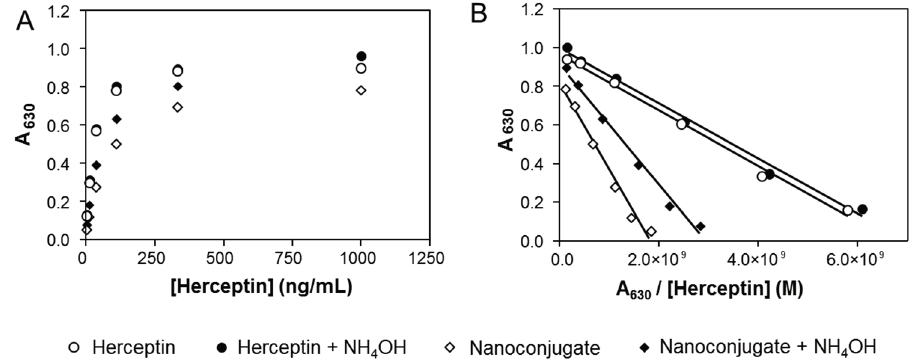
Figure 6. ELISA analysis of Herceptin and nanoconjugate before and after standard ammonolytic treatment. ( A ) Readout from ELISA; ( B ) Replot of ELISA according to Hofstee [24] with A 630 /[C] as x -axis and A 630 as y -axis, where A 630 is the absorbance reading at 630 nm wavelength, and [C] is the concentration of antibody in molar concentration.